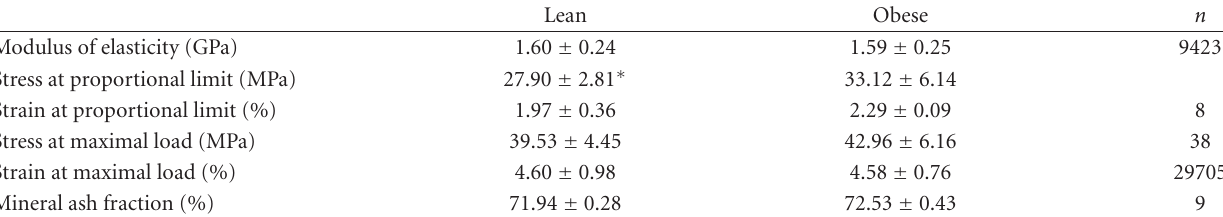
Table 3: Tibial material properties.